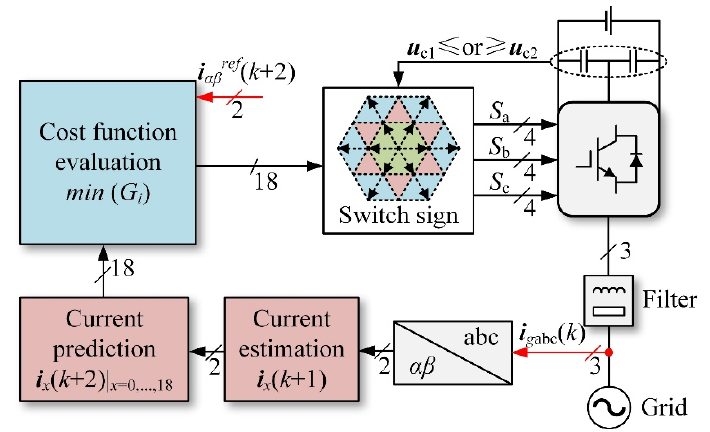
candidate vectors when the capacitor voltage u c1 < u c2 . The control block diagram of MPC is shown in Figure 3.